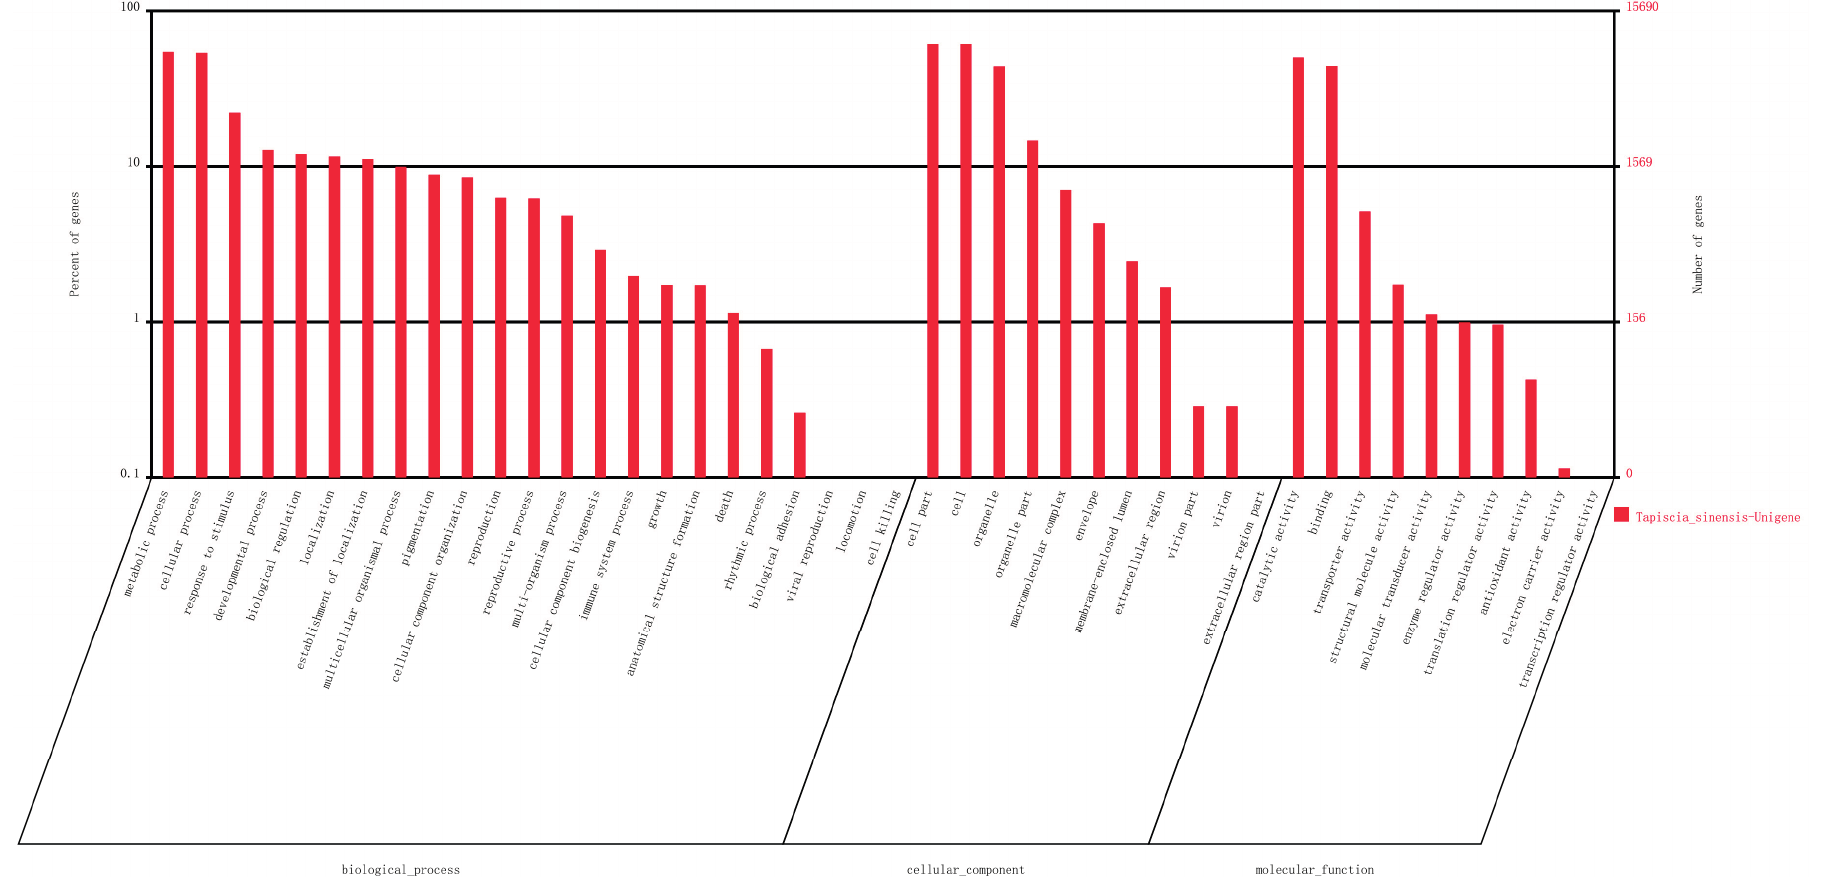
Figure 3. Unigenes were assigned to Gene